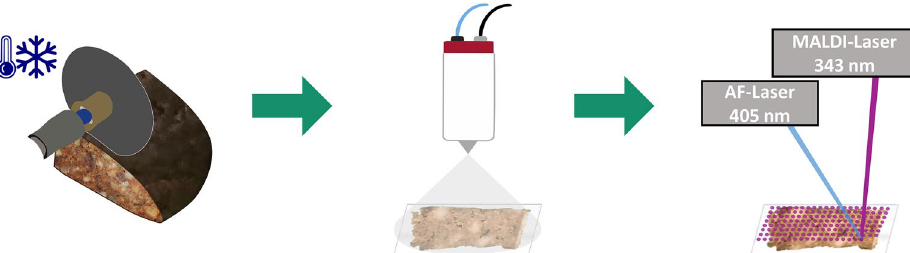
Figure 1. Sample preparation of German gingerbread for MALDI MS imaging experiments. Sections of approx. 2 mm thickness are cut off deep-frozen gingerbread with an electric micro-saw. Sections are glued to an object slide and covered with the MALDI matrix 2.5-dihydroxybenzoic acid (DHB) using an automated sprayer system. The sample is then introduced into an AP-SMALDI5 AF ion source for the autofocusing (AF)